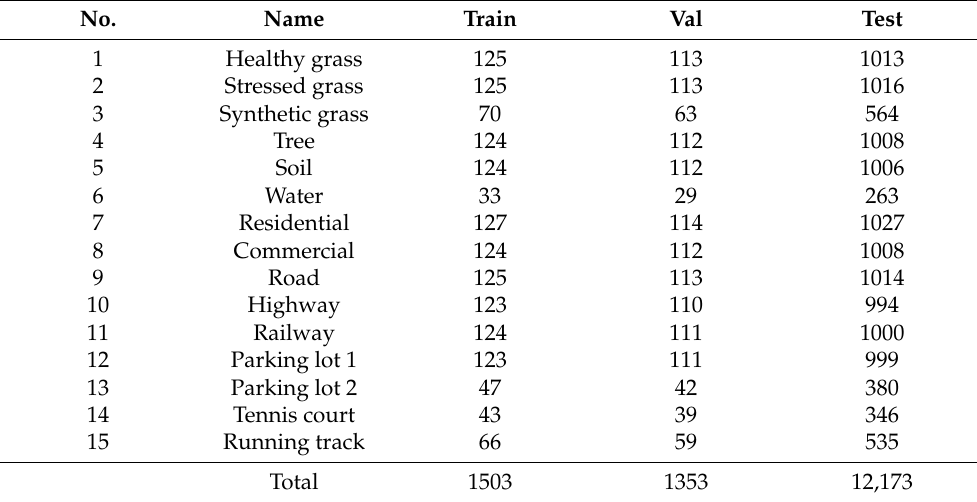
Table 4. The number of training, validation, and testing samples for Grass_Dfc_2013